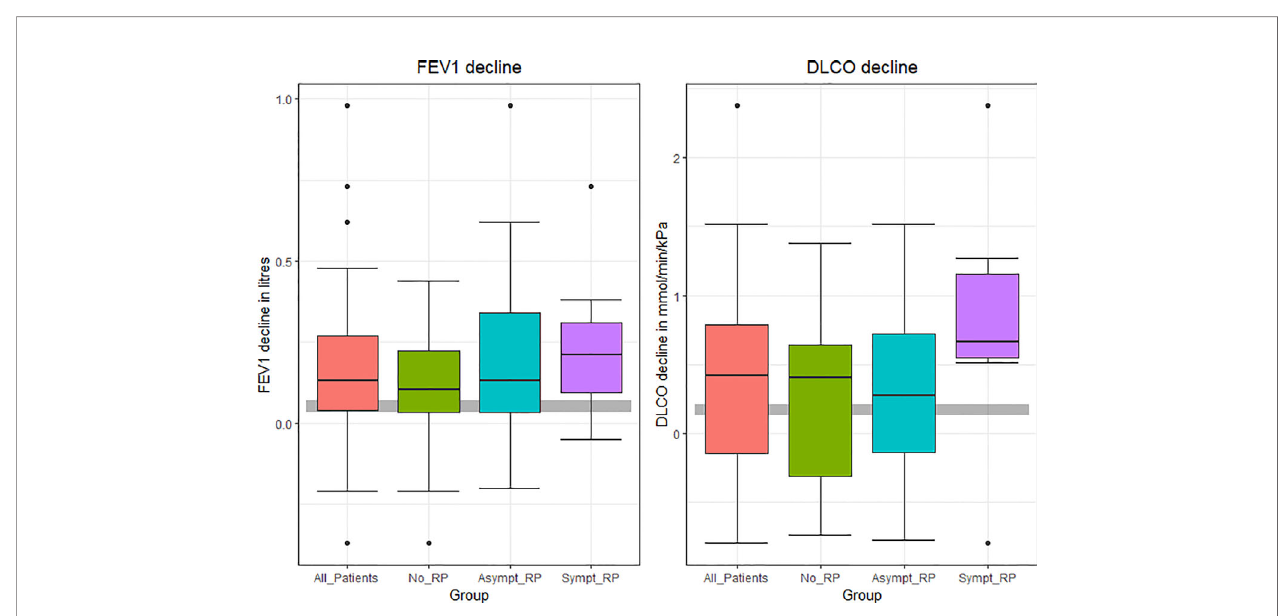
FIGURE 4 | FEV1and DLCO decline in all patients and in three groups after 12 months. The gray stripe is expected physiological